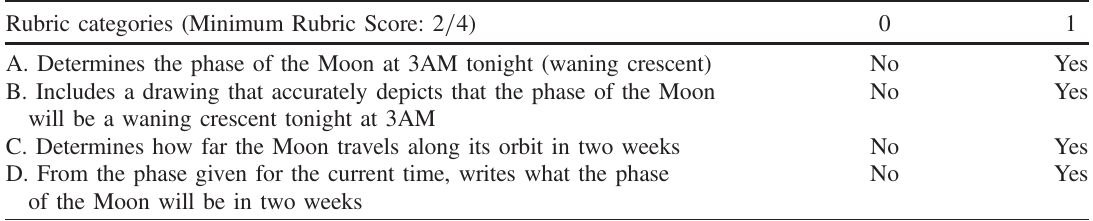
XVIII. Rubric used to determine rubric scores for open-ended responses given to the assessment shown in Fig. 15. Rubric categories (Minimum Rubric Score: 2 = 4 ) 0